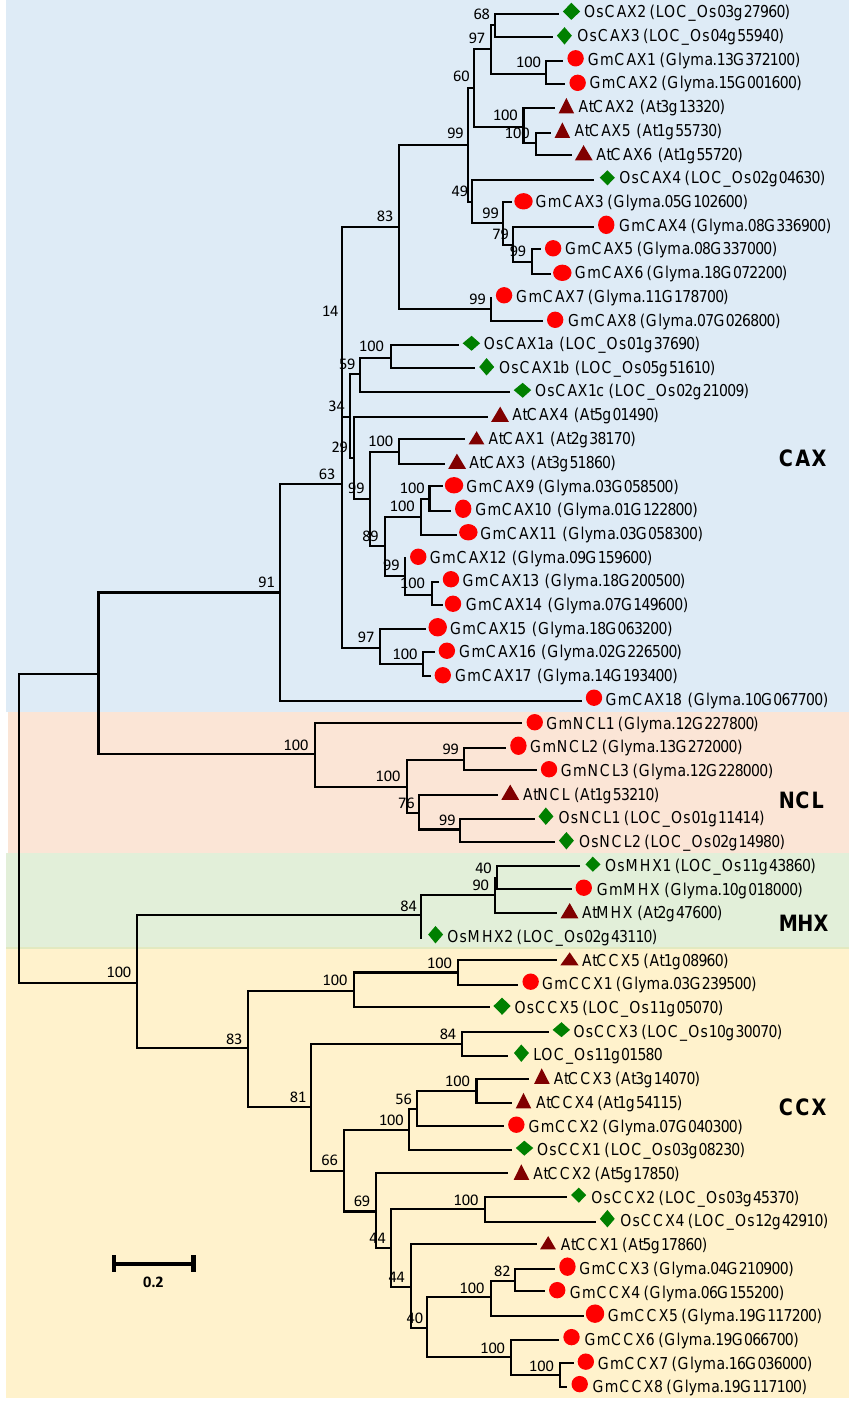
Figure 4. Unrooted phylogenetic tree of the CaCA (Ca 2+ /Cation Antiporter) family proteins from soybean ( Glycine max ), rice ( Oryza sativa ), and Arabidopsis thaliana . The alignment for the phylogenetic tree was performed with ClustalW using full-length amino acid sequences. Soybean CaCAs are marked with red circles, Arabidopsis CaCAs were marked with purple triangles, while rice CaCAs were marked with green diamonds. The bar indicates the relative divergence of the sequences examined, and bootstrap values are displayed next to the branch.